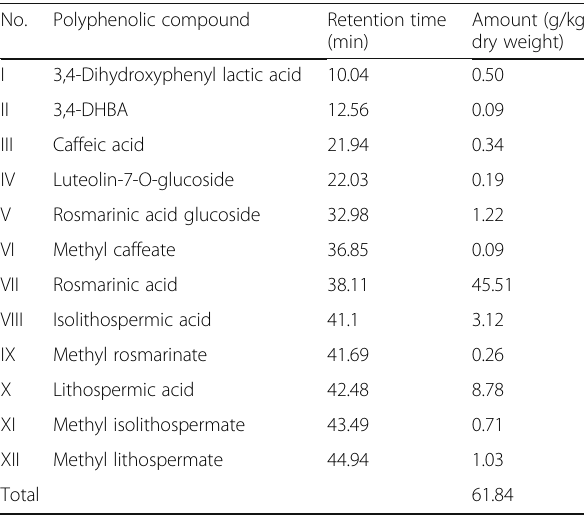
Table 4 Amount of polyphenolic compounds identified in the ethanol extract of Melissa officinalis leaves No.